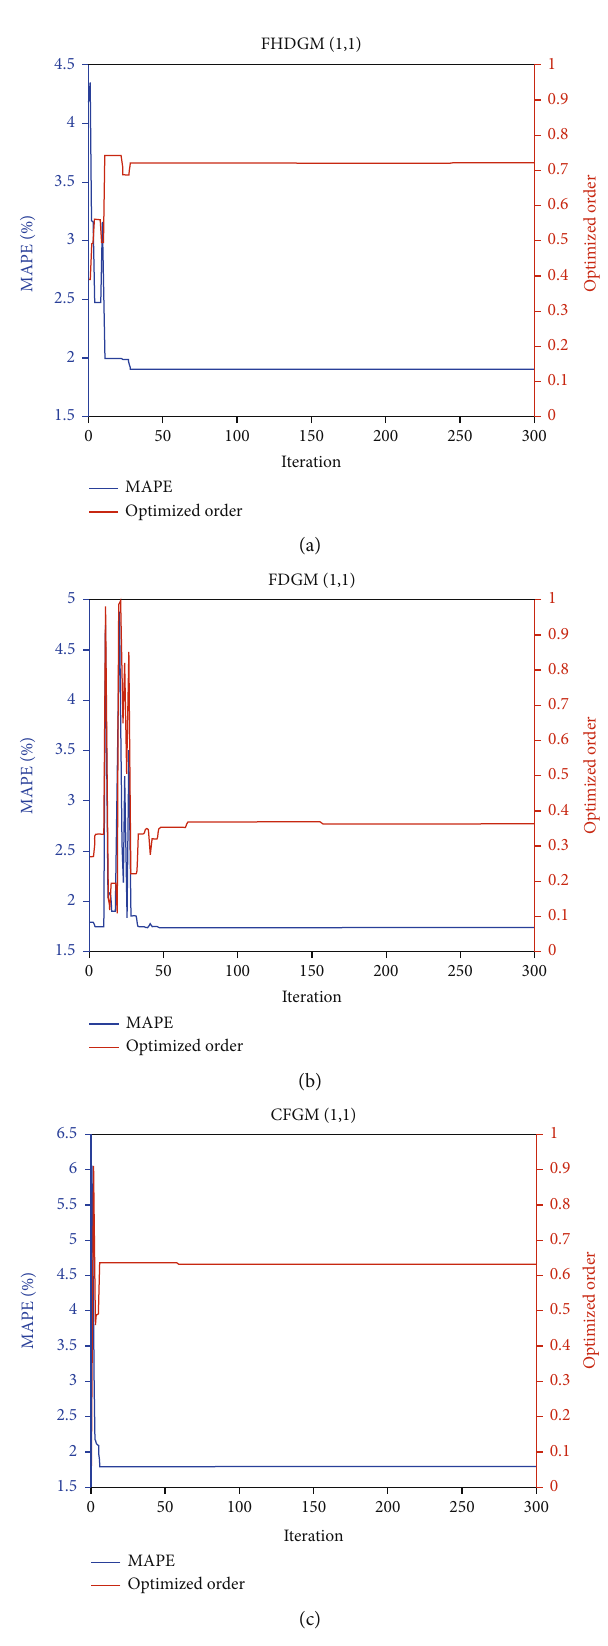
Figure 6: Track related to searching for the minimum MAPE and the optimal